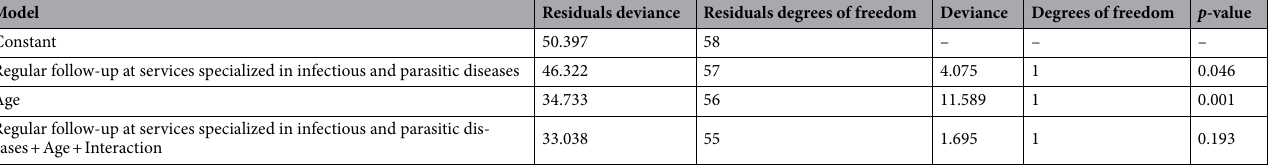
Table 5. Deviance analysis for ART adherence data.